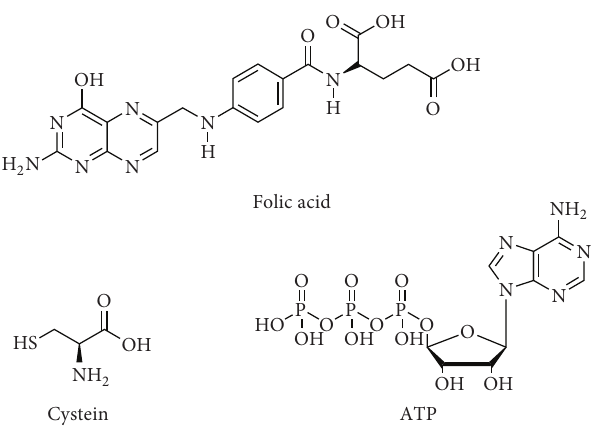
F 2: Structures of some molecules tested with ATP adjuster